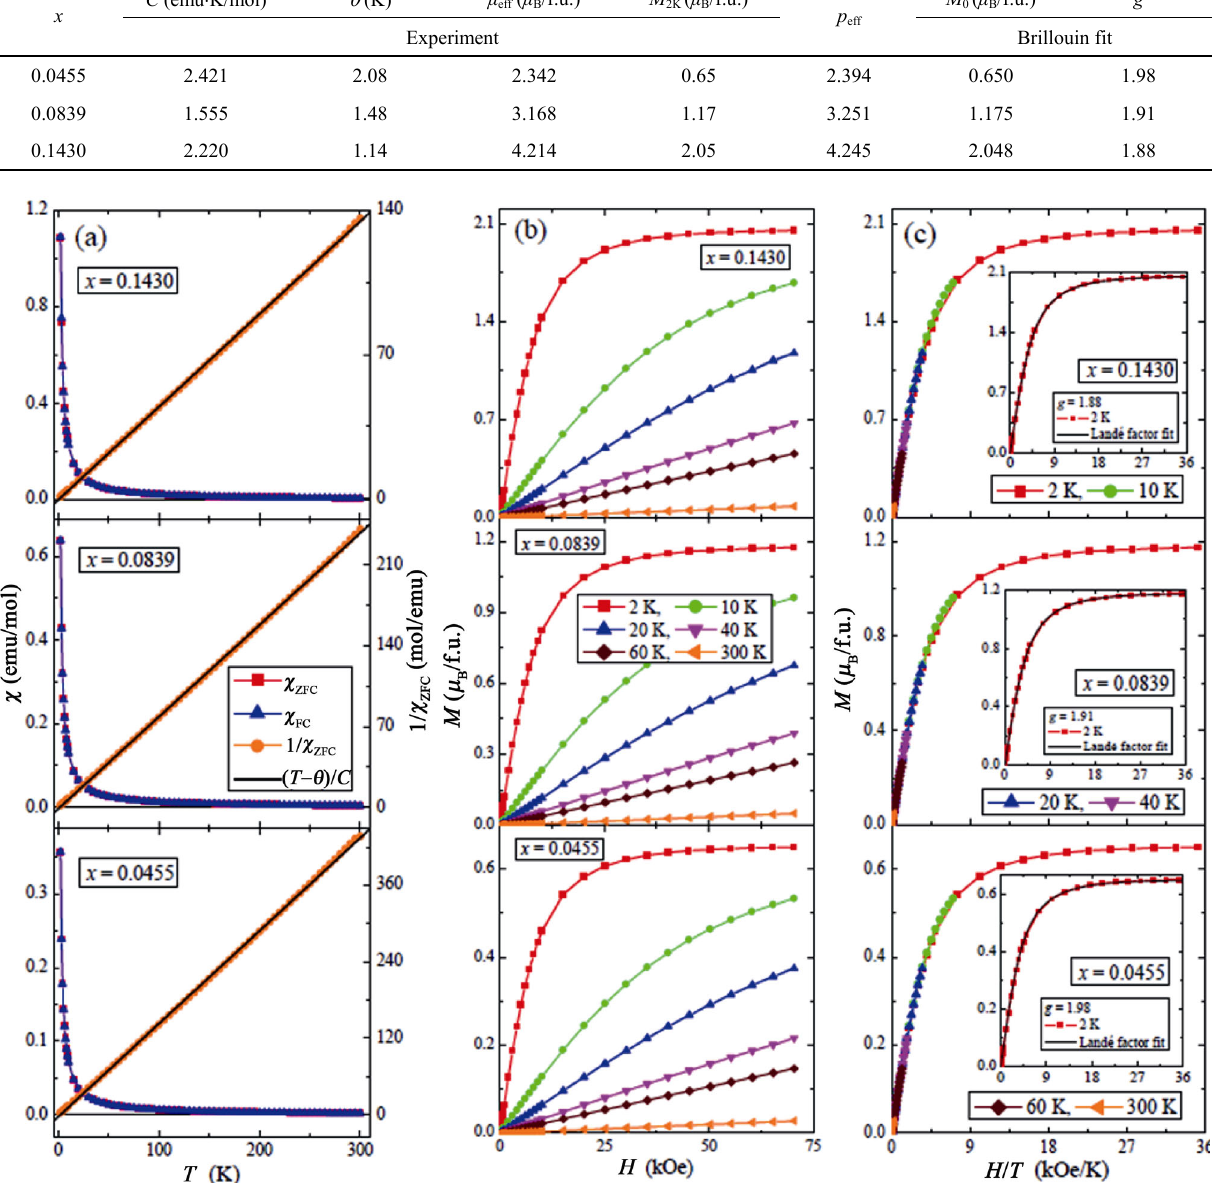
Fig. 6 (a) ZFC and FC magnetic susceptibility and 1/ ZFC vs. temperature T of Pb 1–3 x (cid:0) x Gd 2 x (MoO 4 ) 1–3 x (WO 4 ) 3 x for x = 0.0455, 0.0839, 0.1430 recorded at H = 1 kOe. The solid (black) line, ( T– )/ C , indicates a Curie–Weiss behaviour. (b) Magnetization M vs. temperature T of Pb 1–3 x (cid:0) x Gd 2 x (MoO 4 ) 1–3 x (WO 4 ) 3 x for x = 0.0455, 0.0839, 0.1430 at 2, 10, 20, 40, 60, and 300 K. (c) Magnetization M vs. H / T of Pb 1–3 x (cid:0) x Gd 2 x (MoO 4 ) 1–3 x (WO 4 ) 3 x for x = 0.0455, 0.0839, 0.1430 at 2, 10, 20, 40, 60, and 300 K. Inset: Landé factor fit (solid black line) to the experimental data at 2